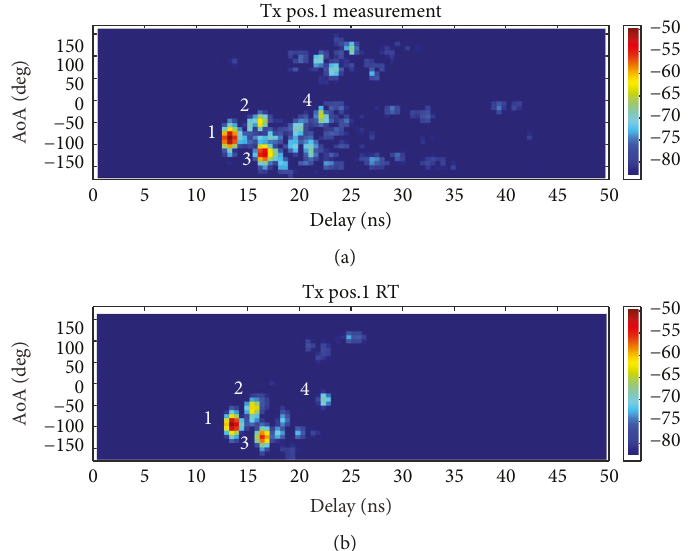
Figure 16: Measured (a) and RT-simulated (b) power-angle-delay pro fi le for Tx position 1 in the small o ffi ce LOS